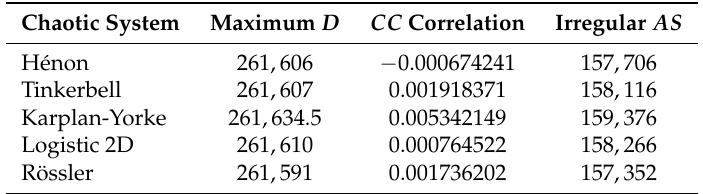
Table 11. Encryption quality algorithm by using the Cameraman cryptogram. Chaotic System Maximum D CC